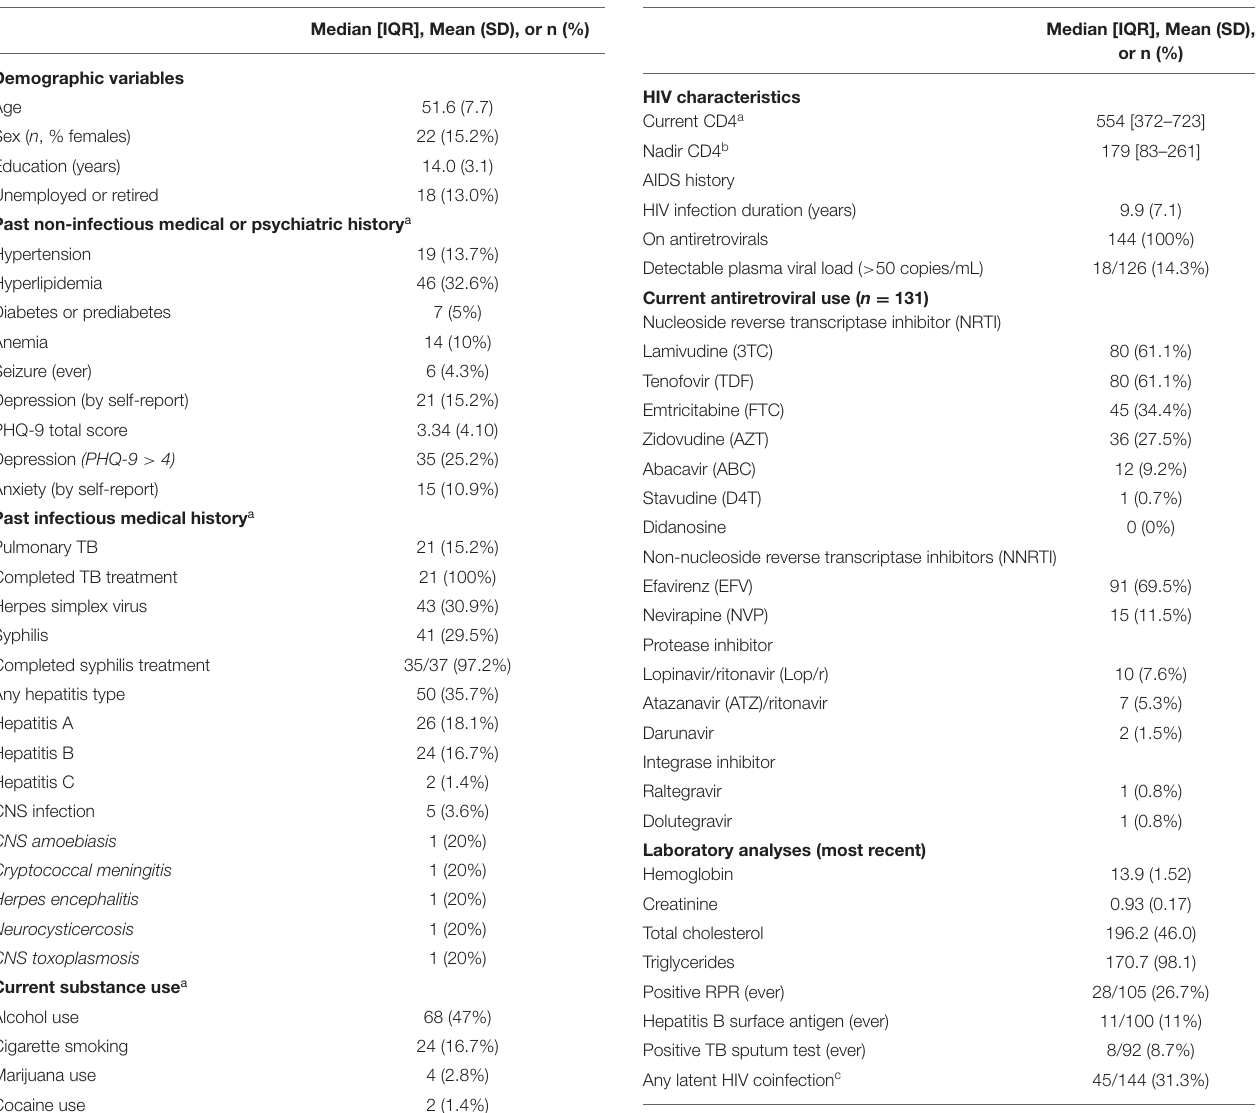
TABLE 1 | Demographic and medical characteristics ( N = 144). TABLE 2 | HIV characteristics and laboratory results ( N =